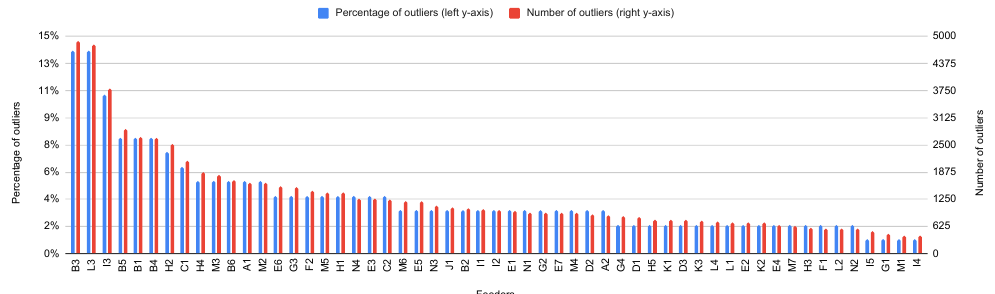
Figure 1. Combo bar chart representing the percentage and total numbers of outliers detected on each